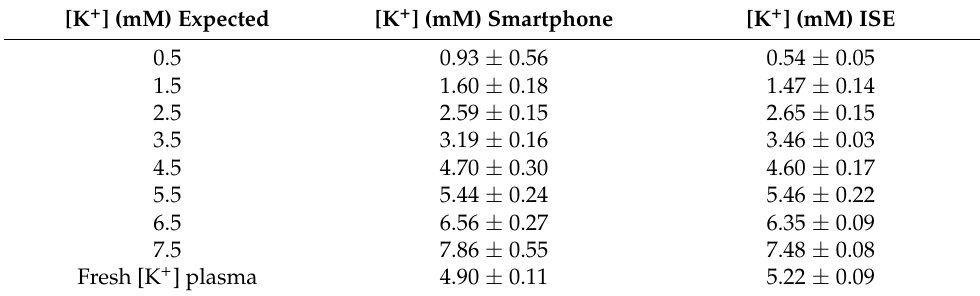
Figure 6. Plot of [K + ] of the treated blood plasma samples obtained by the smartphone device and ISE device. Table 1. Comparison of [K + ] in treated blood samples obtained with smartphone and ISE device.